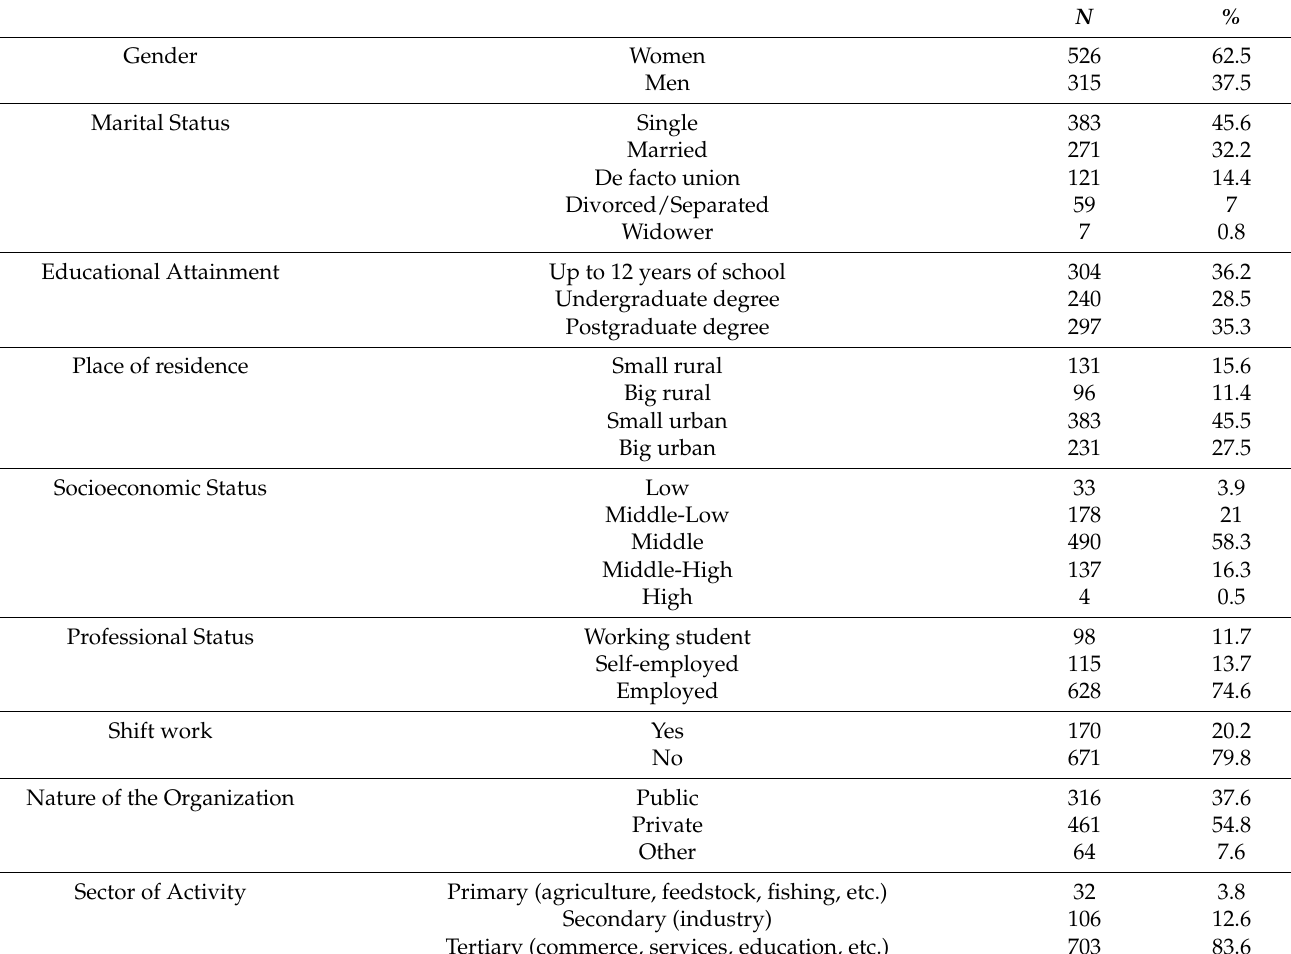
Table 1. Sociodemographic characteristics of the participants ( N = 841; M age = 37.23; SD = 11.99; M workload = 36.20; SD = 11.89).